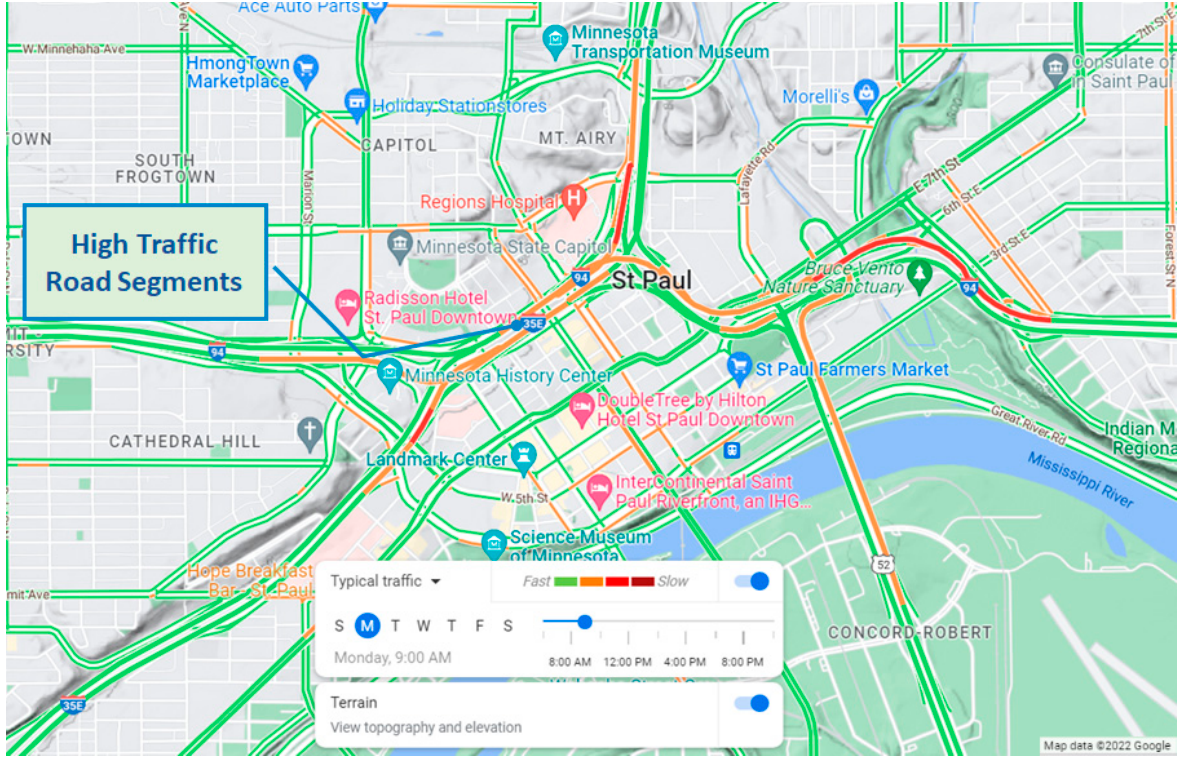
Figure 3. Location of High-Traffic Road Segments on the Interstate-35E. Map Data: Google Maps.